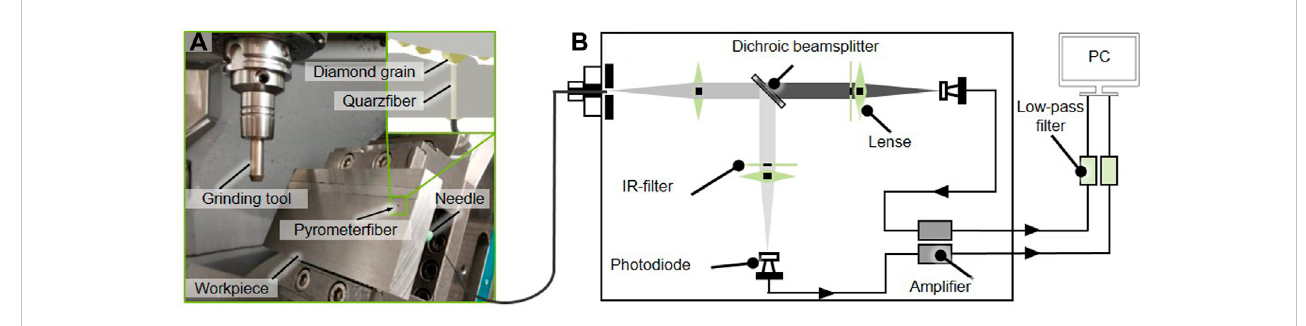
FIGURE 9 (A) Experimentalsetupfor insitu measurementofsingle graintemperatureswithatwo-color pyrometer. (B) SchematicrepresentationoftheEn2Aixfast fi ber-optic two-color pyrometer Fire III (Müller and Renz,